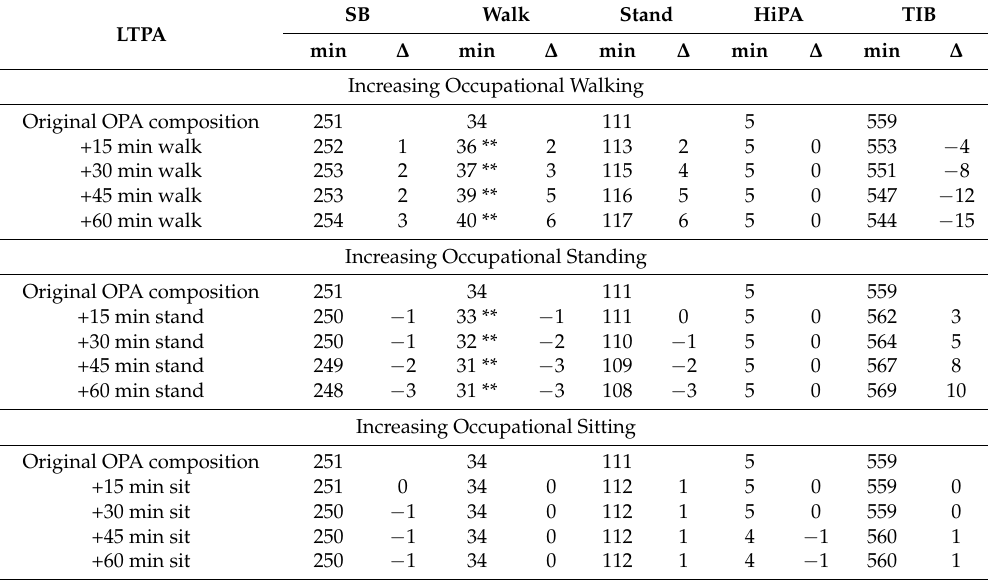
Table 5. Expected difference in LTPA following reallocation between occupational physical activities among men (N =